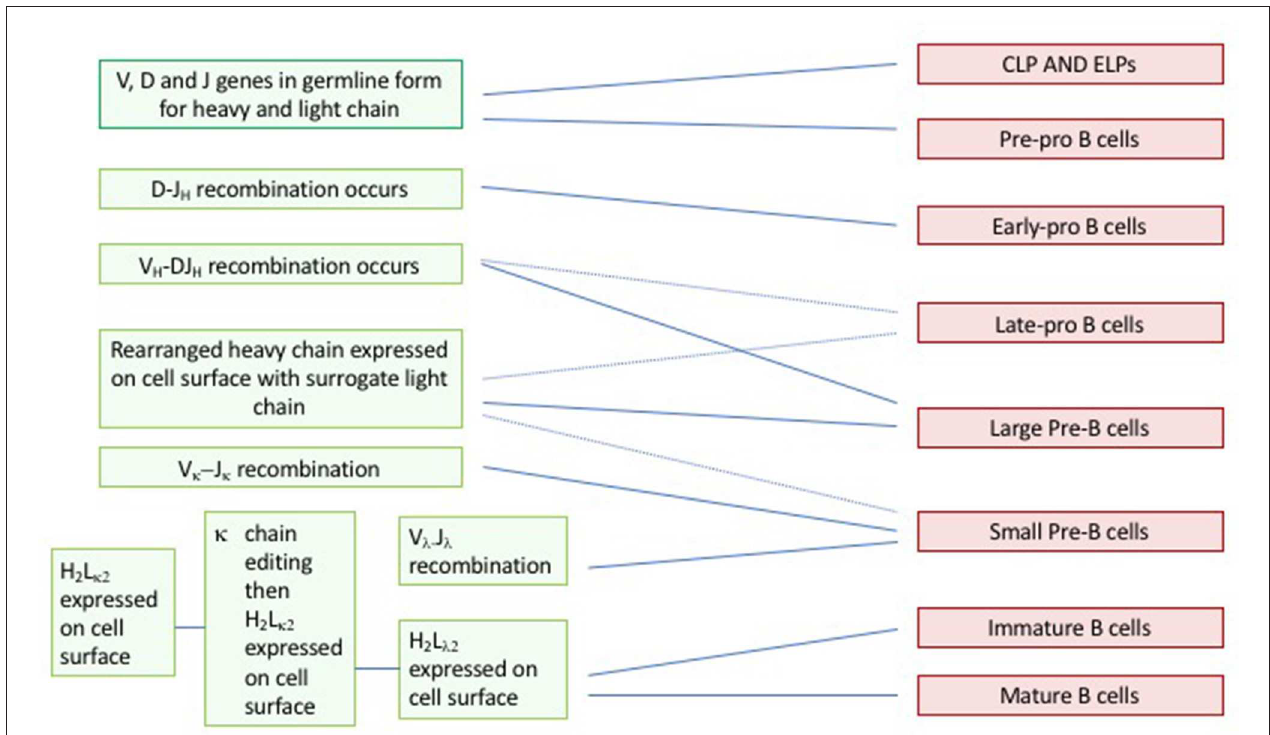
FIGURE 3 | Student-generated B cell development concept map. B cell development concept map. Working in groups of two to four, students arrange the sticky notes on a poster chart in two vertical lines, representing the chronological sequences of events or differentiation states. Next, they draw the horizontal lines that connect the stage of gene rearrangement with the stage of B cell